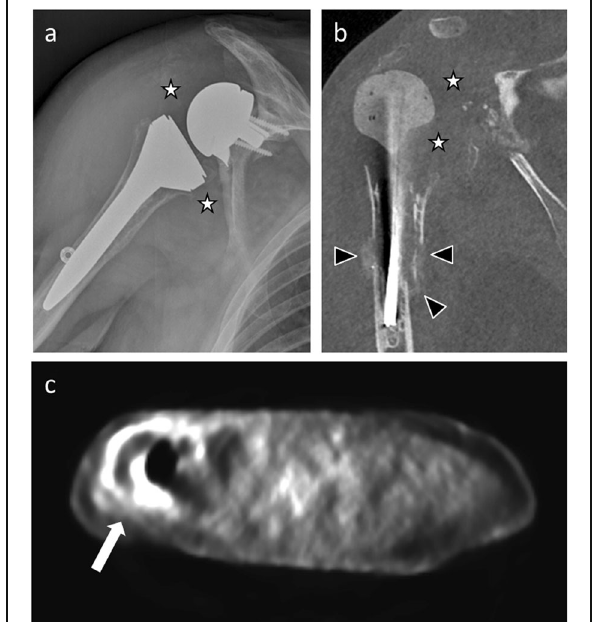
Fig. 6 a Anteroposterior radiograph of a 73 years-old man with periprosthetic joint infection shows a soft-tissue thickening (white stars) around the reverse shoulder arthroplasty. b Coronal CT image of the same patient as in a , immediately after surgical revision and placement of a spacer, shows the same soft-tissue thickening (white stars), focal cortical losses, and periosteal appositions (arrowheads). c Axial FDG-PET image of the same patient as in a before surgery shows abnormal uptake around the prosthesis